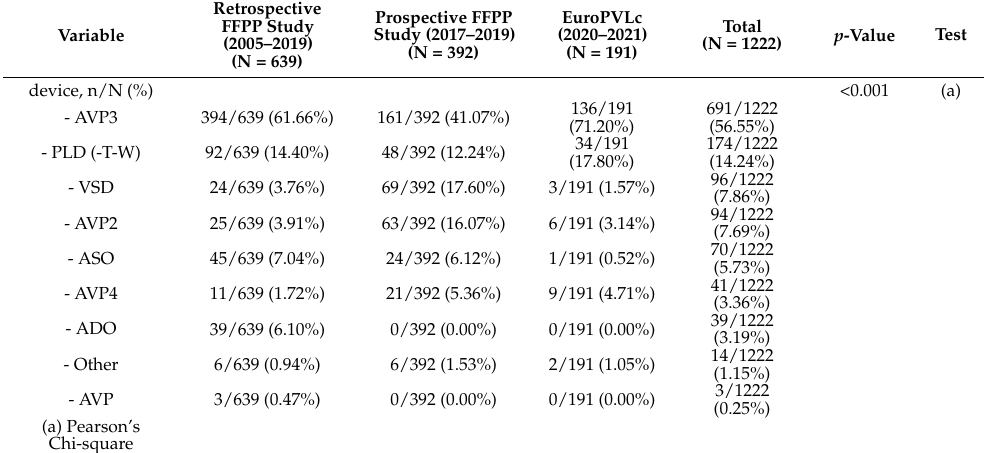
Table 6. List of devices implanted in patients included in the retrospective FFPP registry, prospective FFPP registry, and EuroPVLc